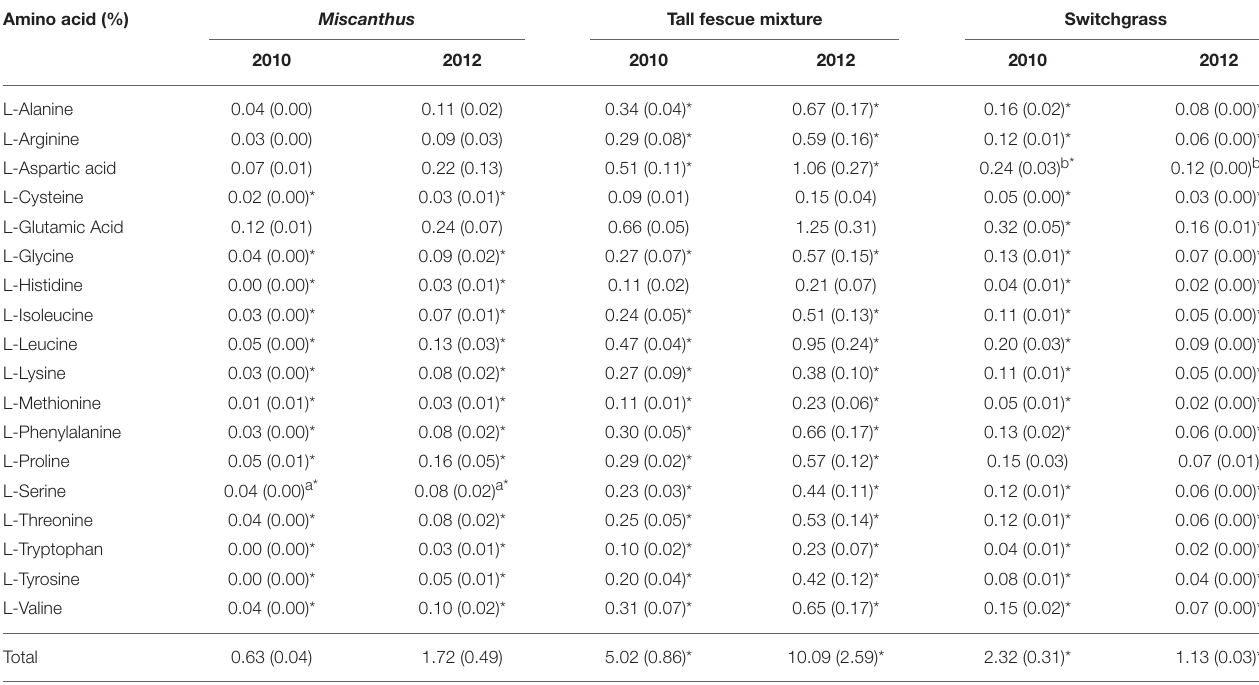
Asterisks indicate significant differences from a one-way, repeated measures ANOVA comparing 2010 with 2012 for each feedstock separately (p ≤ 0.05). a Reciprocal transformed to meet assumptions of equal variance. b Natural-log transformed to meet assumptions of equal variance.